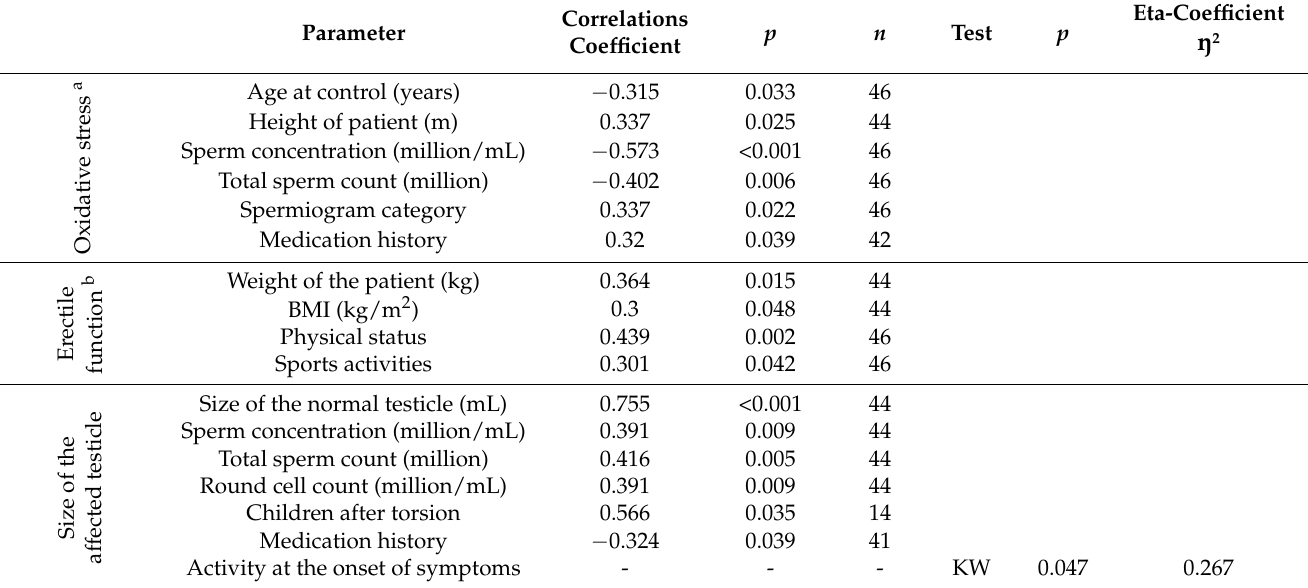
Table 6. Analysis of correlations between oxidative stress (OS), erectile function, size of the affected testis, and the investigated parameter.